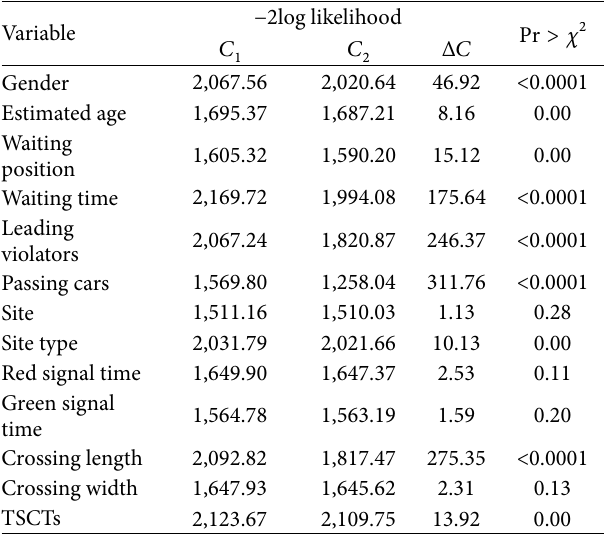
Table 9: Results of univariate analysis for all